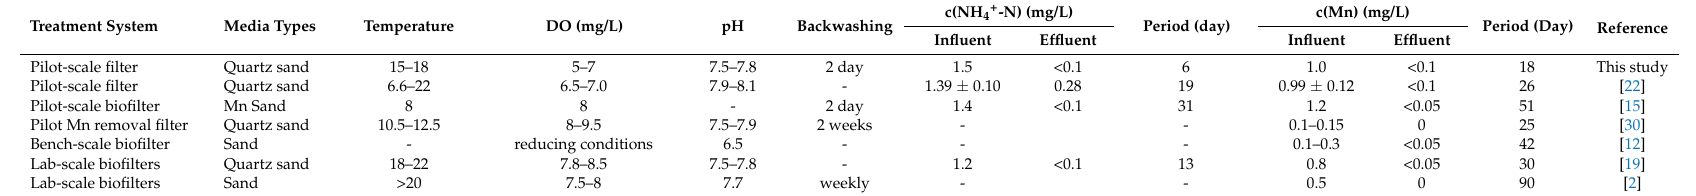
Table 4. The comparison of the start-up period of NH 4+ -N and Mn 2+ with other